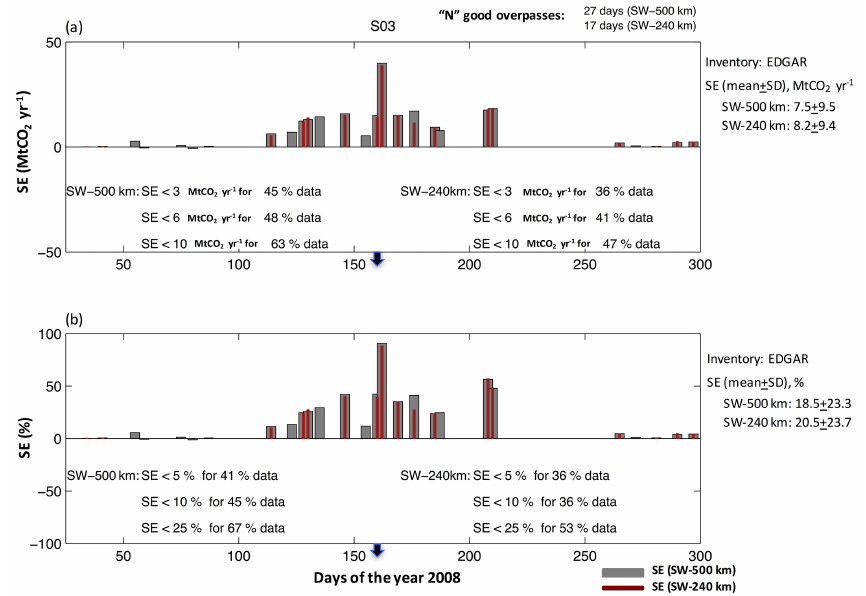
Figure 11. Same as Fig. 9, but for S03, quantifying the impact of the worst-case modelling-related errors by assuming that biogenic XCO 2 variations cannot be modelled at